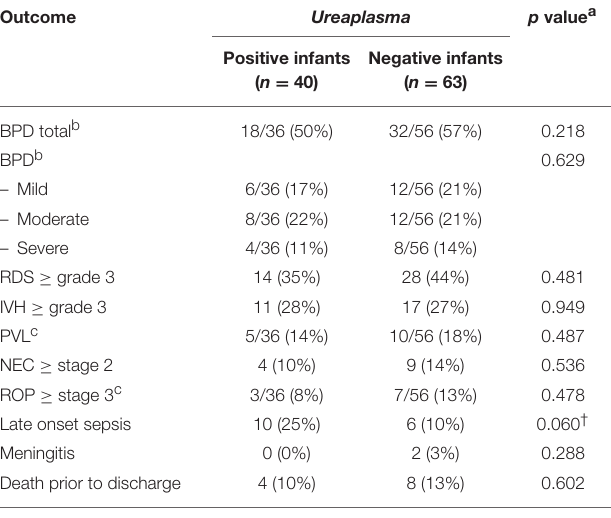
TABLE 1 | Prenatal, perinatal, and postnatal characteristics of study infants. Characteristic Ureaplasma